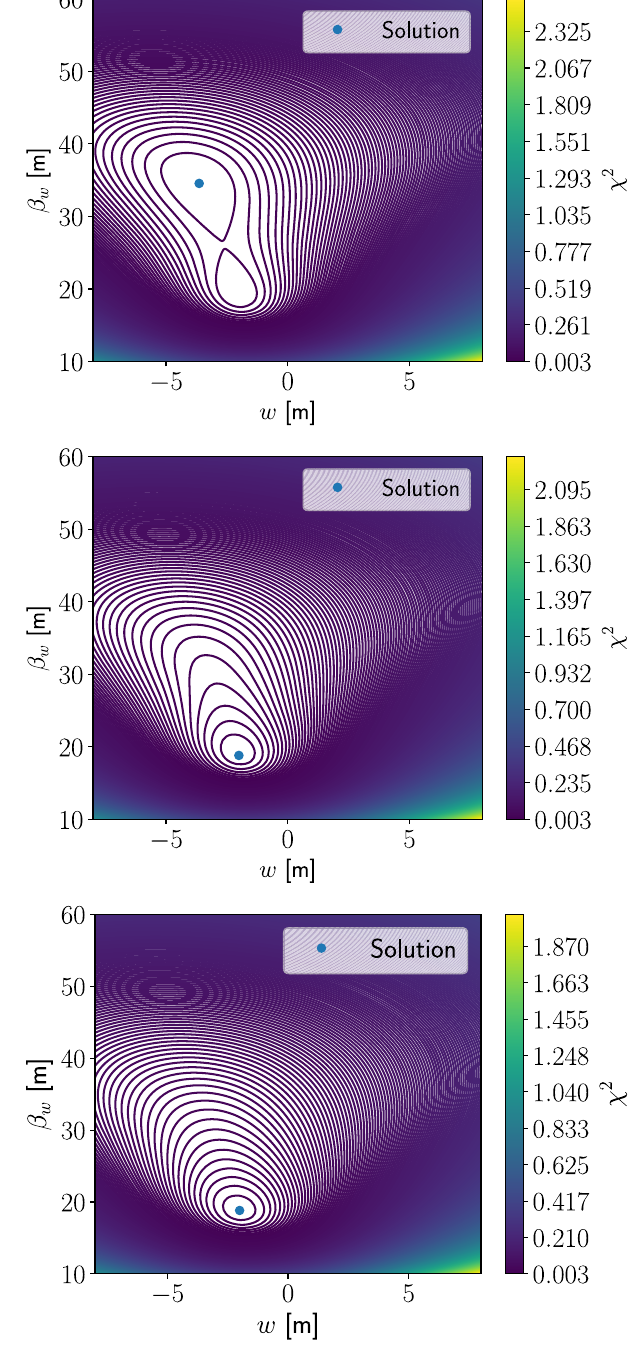
FIG. 7. Example of how the optimization algorithm can converge to the wrong solution (top) and how the introduction of the phase advance constraint [ Ω ¼ 0 . 1 (middle) and Ω ¼ 0 . 2 (bottom)] helps in finding the real minimum for the case of vdM optics algorithm converges to the nonoptimal solution. In Fig. 9 (top), the relative number of seeds converging to the right minimum is shown as a function of the weight Ω .